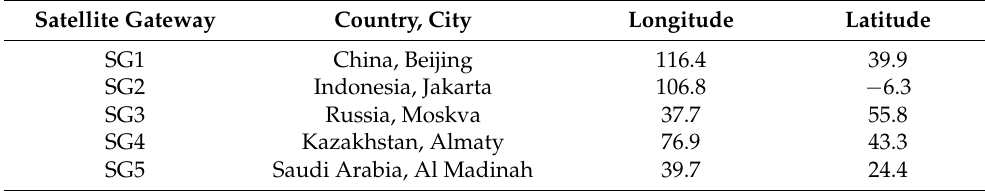
Table 2. Distribution of satellite